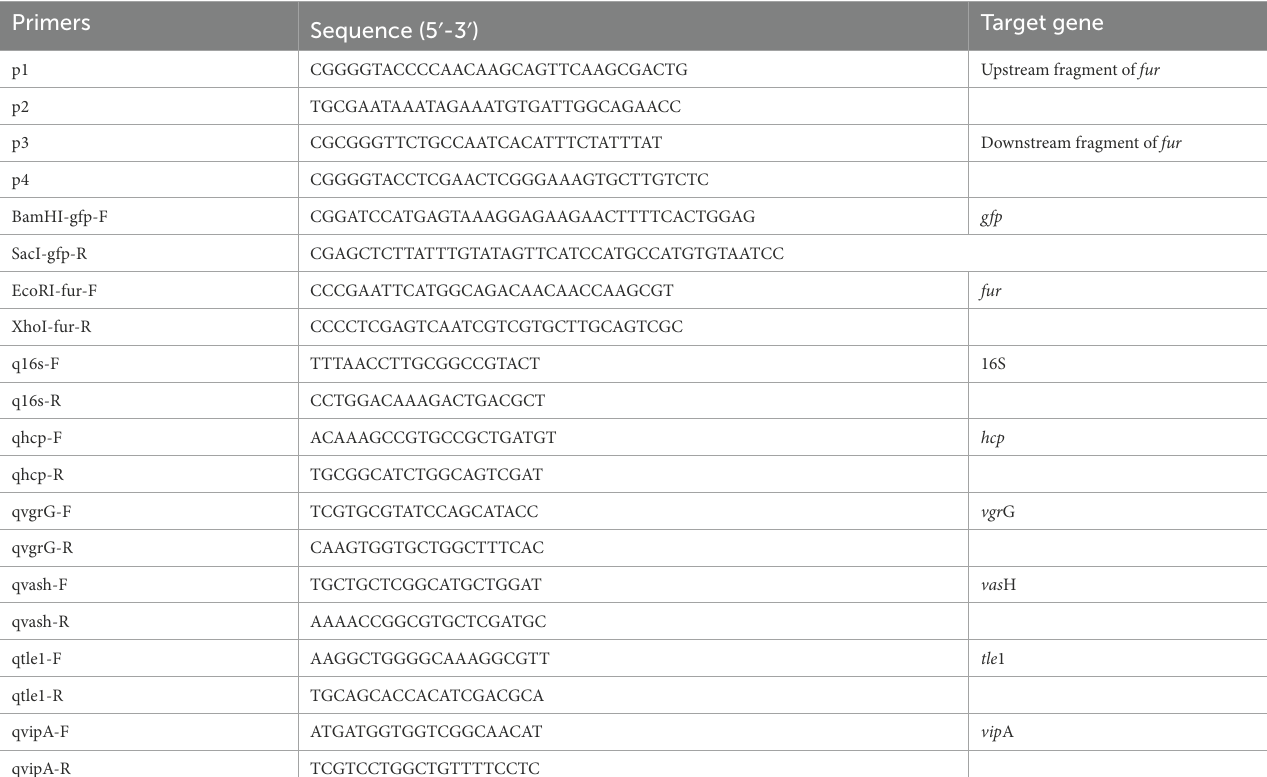
TABLE 2 Primers used in this